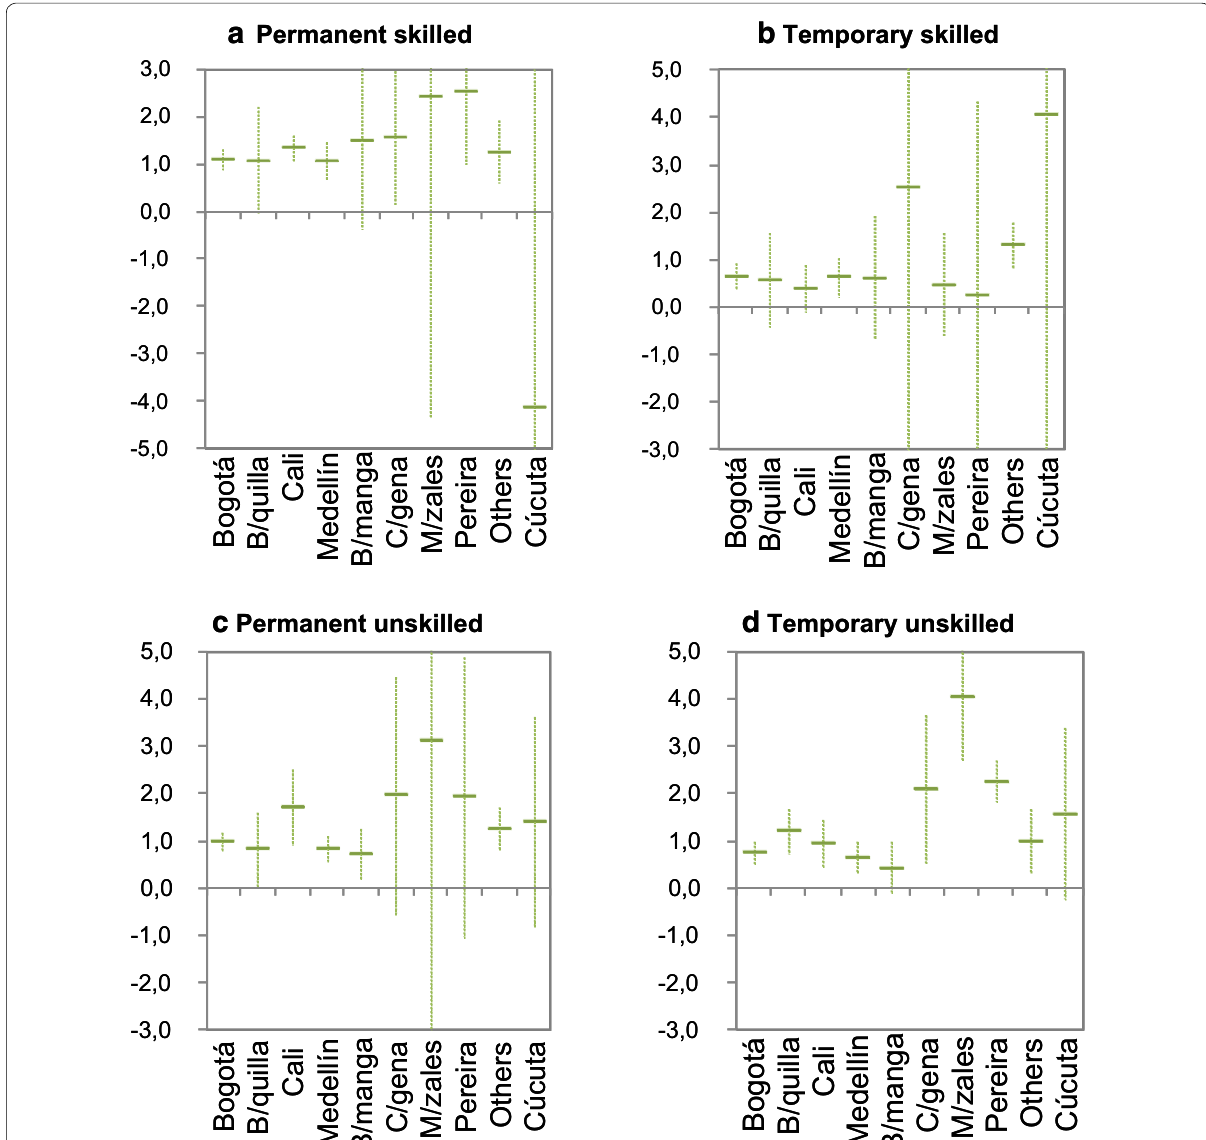
Fig. 6 Long-run output elasticity of conditional labour demand (2000–2013). 95% confidence intervals ( Source Dane-AMS and authors’